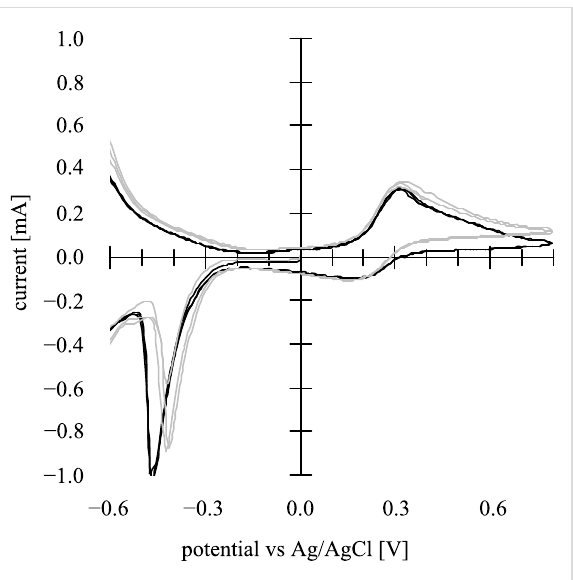
Figure 6: Cyclic voltammogram in the dark (black line) and with light ir- radiation (gray line) at a nanoporous TiO 2 photoanode (1 cm × 1 cm) in a 400 μ M [Fe(CN) 6 ] 4 − aqueous solution (+ 0.1 M Na 2 SO 4 , pH 8.5) under an Ar atmosphere with MEA (1 cm × 1 cm) as the counter elec- trode and Ag/AgCl as the reference electrode. Light intensity 3.5 mW·cm − 2 (UV-A region). Scan rate: 100 mV·s − 1